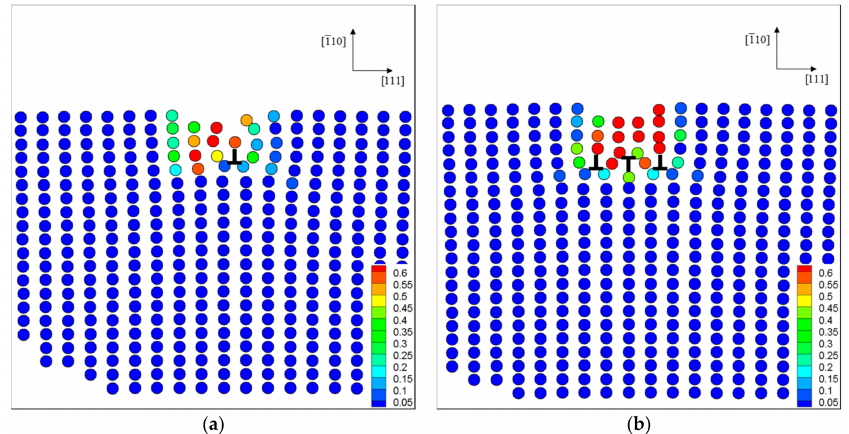
Figure 8. Strain distribution and atom configurations of Al bulk material under the wedged indenter with half vertex angle of 70 ◦ after retractions at B 2 ’ and C 2 ’: ( a ) U 2-2 ; ( b ) U 2-3